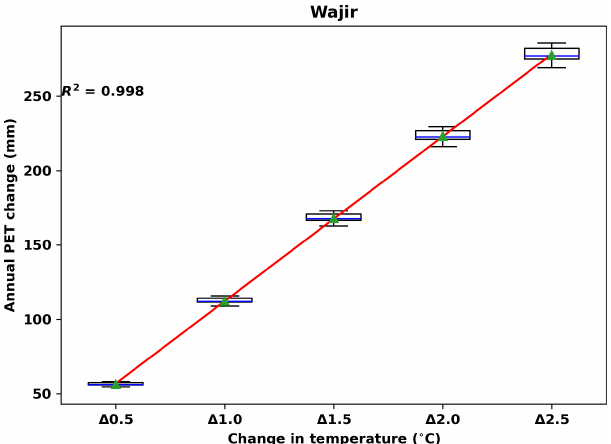
Figure 13. Annual PET change when estimated by progressively increasing the atmospheric air temperature. The changes are refer- enced to hPET, which is calculated using the historical temperature. This example is for a single location (Wajir, Kenya). The red line in- dicates the regression line, with a coefficient of determination ( R 2 ) of 0.998.